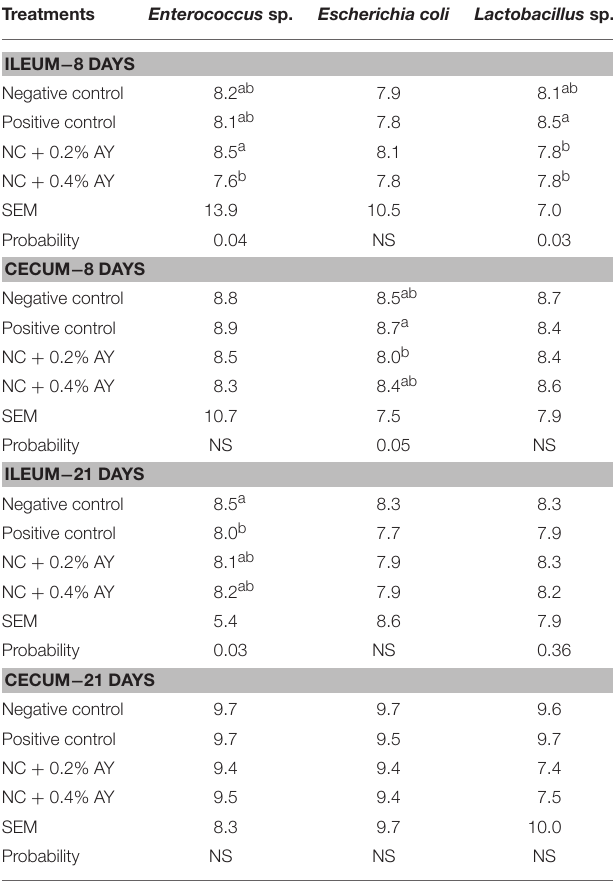
TABLE 5 | Bacterial enumeration (log 10 CFU/g) from the ileal and cecal digesta of broiler chickens supplemented with zinc bacitracin or autolyzed yeast of Saccharomyces cerevisiae